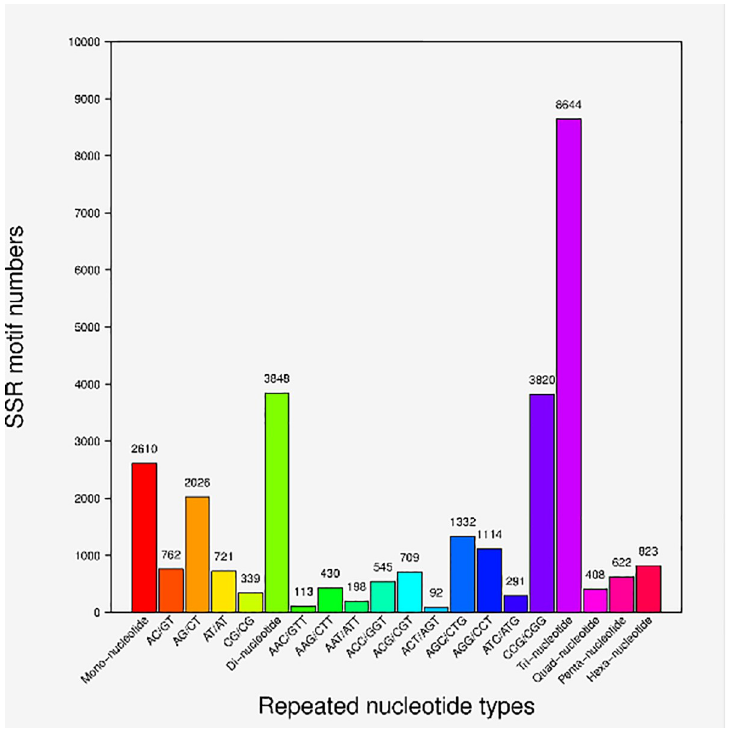
Fig 8. Statistics of Simple Sequence Repeats (SSRs) taxonomy of Coix lacryma-jobi L.